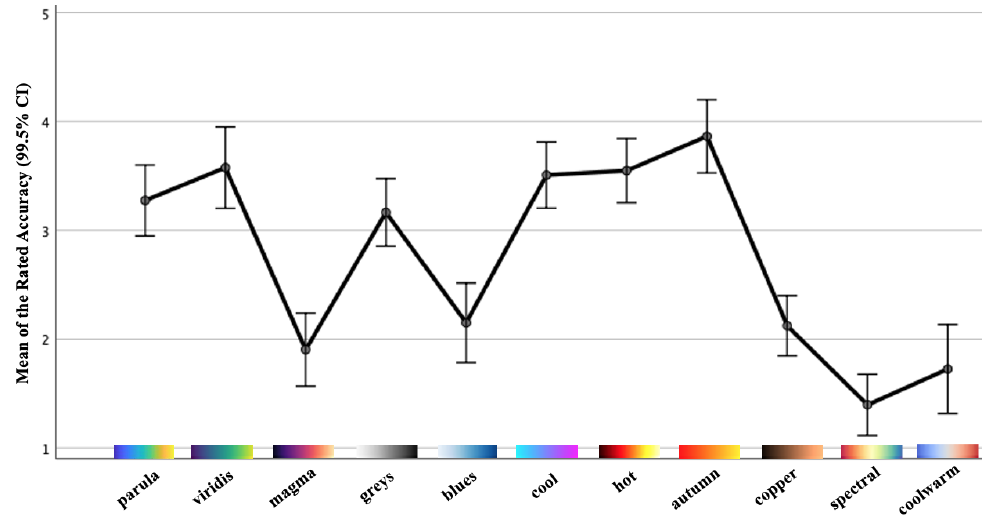
Figure 14. Mean values with standard errors (99.5% CI) of the colormap accuracy rated by